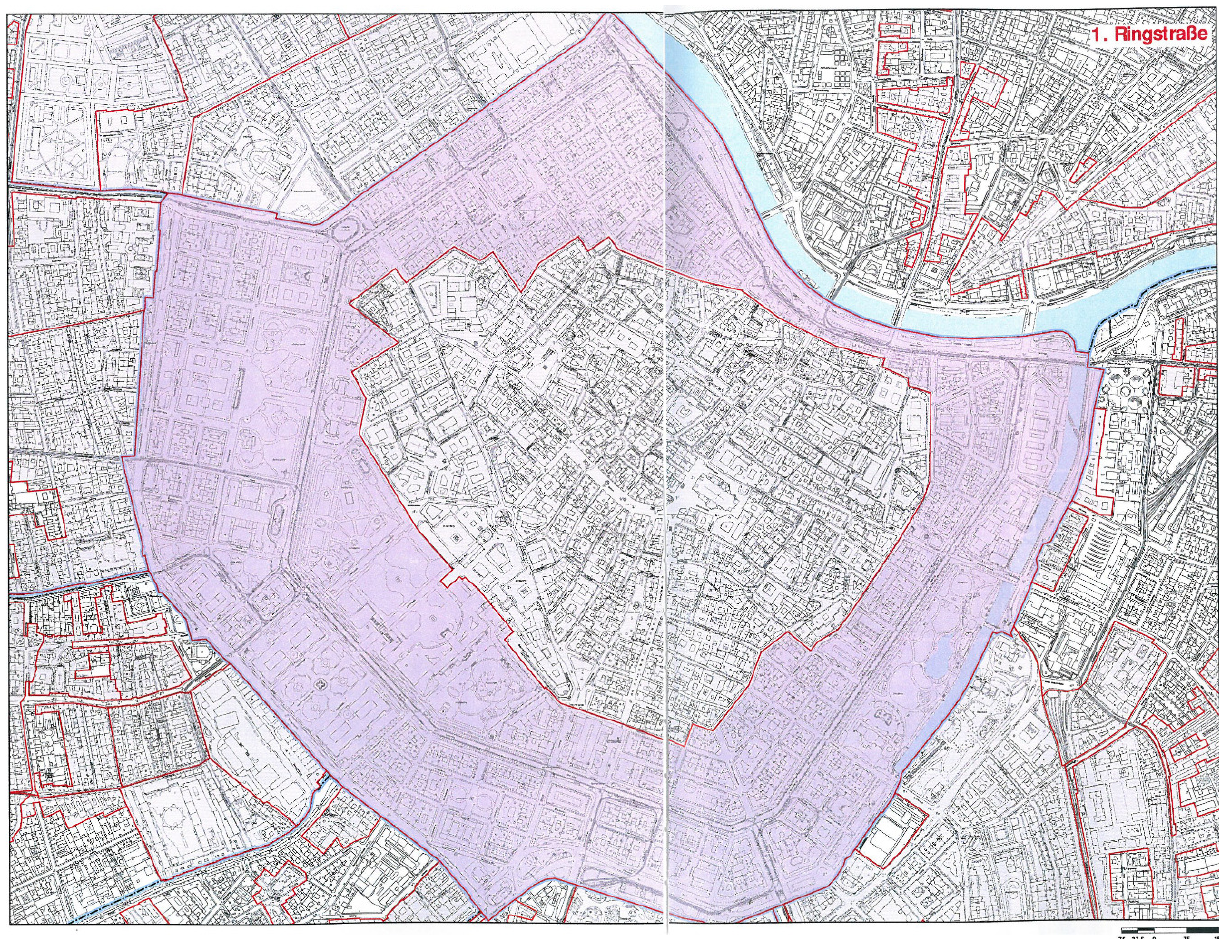
Figure 5. Schutzzone Ringstraße: Map showing the situation in 2004. Source: Stadtplanung Wien (2005, pp.